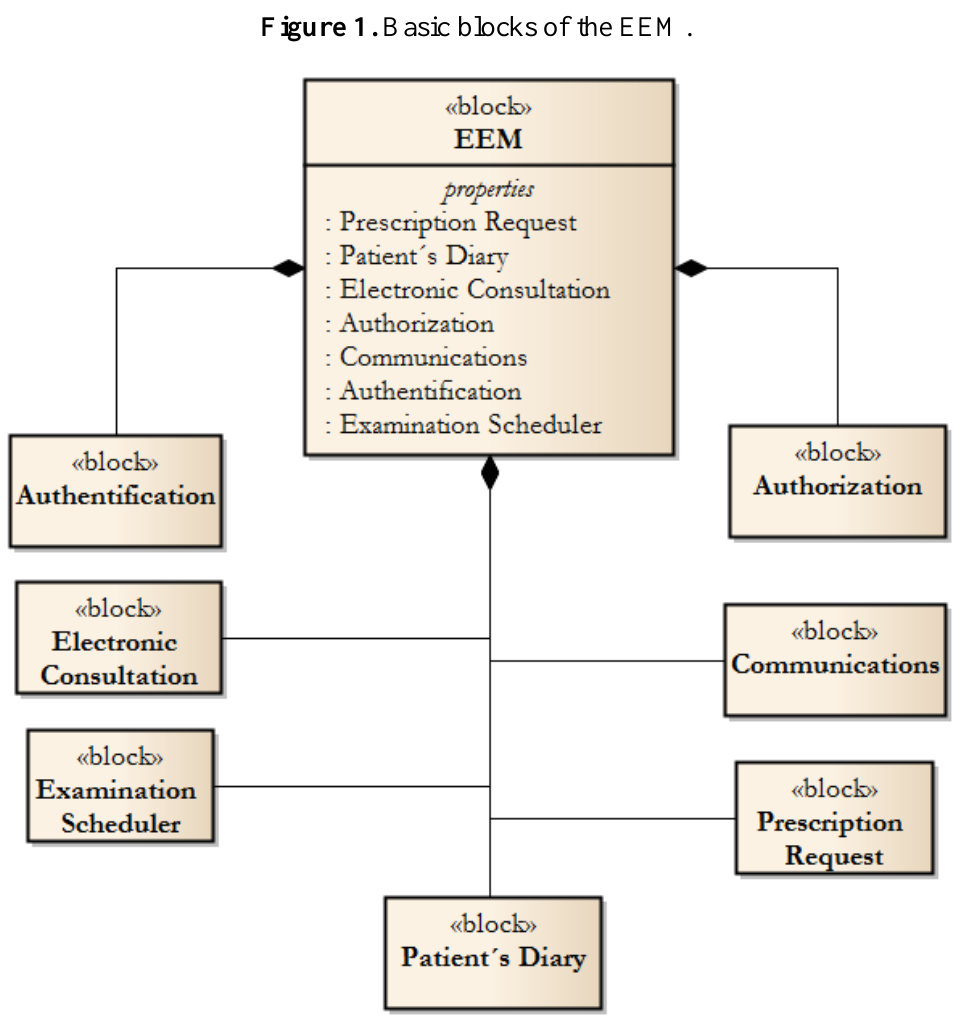
Figure 1. Basic blocks of the